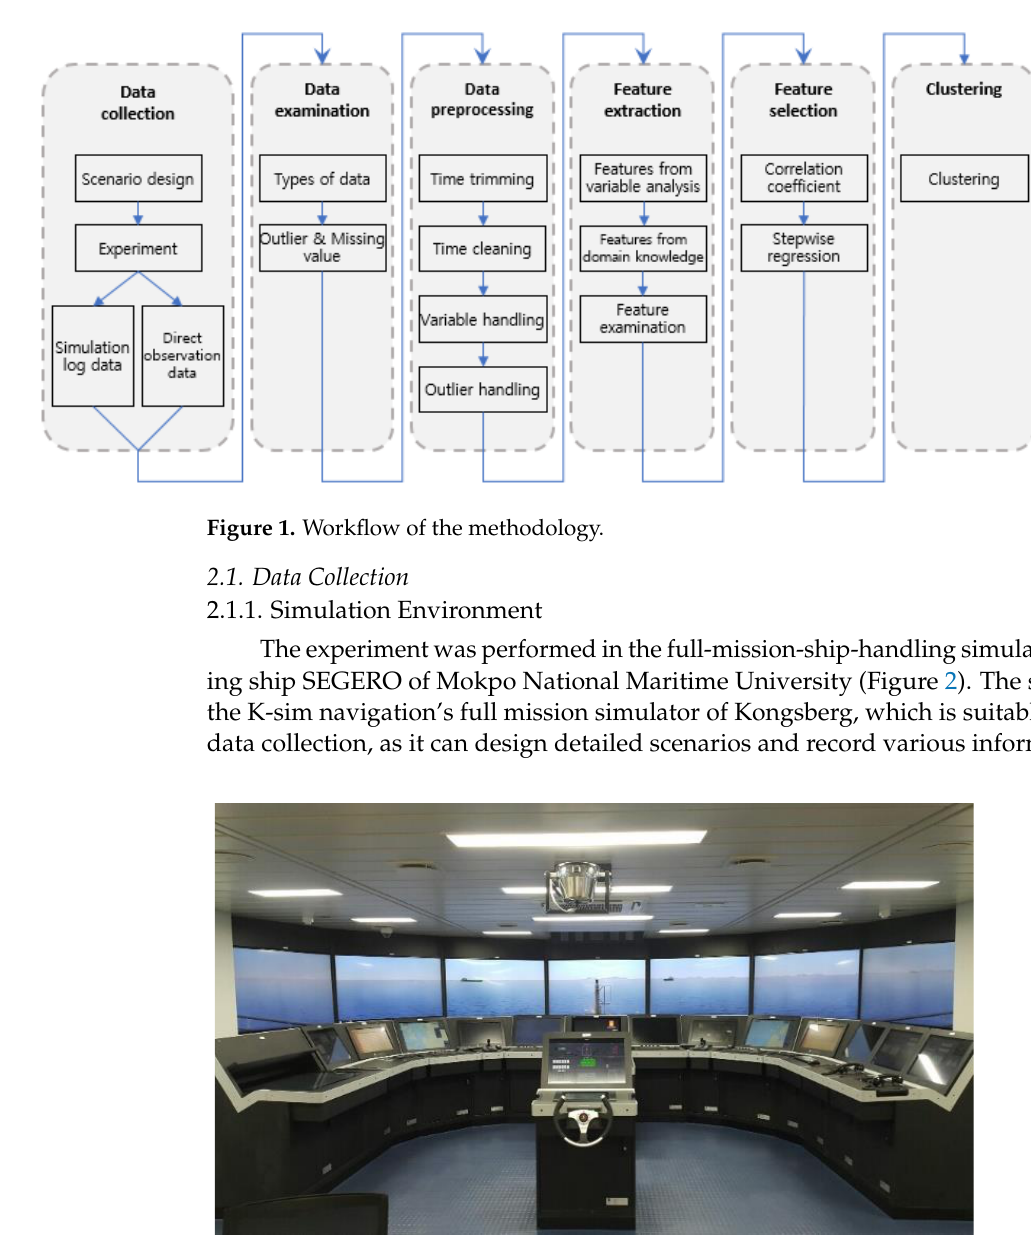
Figure 2. Full-mission-ship-handling simulator for the simulation experiment.